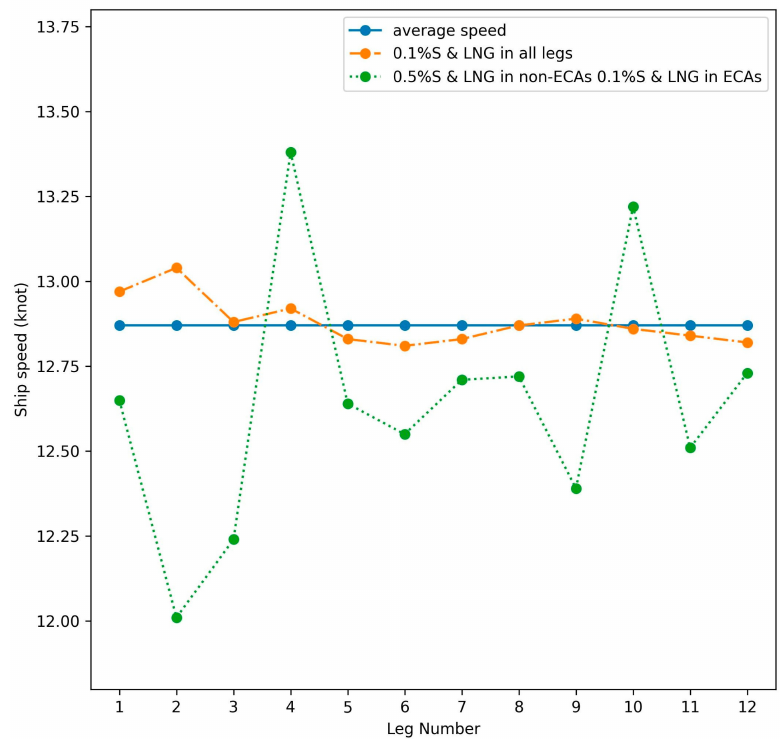
Figure 9. Theoretical average speed (blue, solid line), cost minimization optimal speed (orange dashed dotted line and green dotted line) in all legs represent the Scenario 2 and Scenario